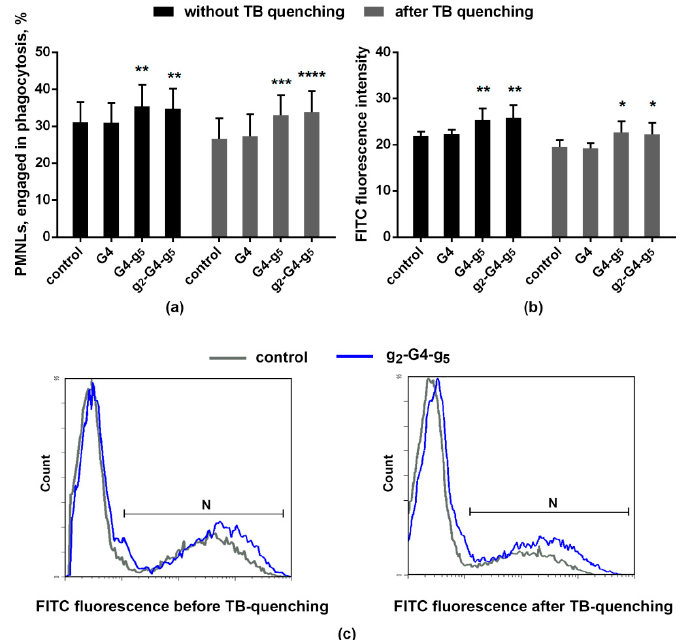
Figure 1. E ff ect of ODNs on polymorphonuclear leukocyte (PMNL) phagocytic activity. Neutrophils (10 6 in HBSS / HEPES) were incubated for 15 min at 37 ◦ C in 5% CO 2 with no additives (control probe) or in the presence of 1 µ M ODN. Then, opsonized fluorescein-isothiocyanate (FITC)-labeled S . typhimurium cells were added for 20 min. The fluorescence of surface bound bacteria was quenched by trypan blue (TB) solution. Presented are pooled flow cytometry data with numbers of phagocytizing (i.e., FITC-positive, gate N on ( c )) cells, as a percentage of the total number of PMNLs in the sample ( a ) and fluorescence intensities of FITC-positive subpopulations ( b ) without (black bars) or after (grey bars) TB quenching. Values indicate means ± SEMs for five independent experiments performed in triplicate; *, **, ***, and ****, p < 0.05, 0.01, 0.005 and 0.001, respectively, compared to the control probe as indicated by two-way ANOVA followed by Tukey’s multiple comparison test. ( c ) Representative histograms of control (grey) and g 2 -G4-g 5 -treated (blue) samples, demonstrating ODN e ff ect on the proportion of cells interacting with bacteria (gate N), without (left) and after (right) treatment with